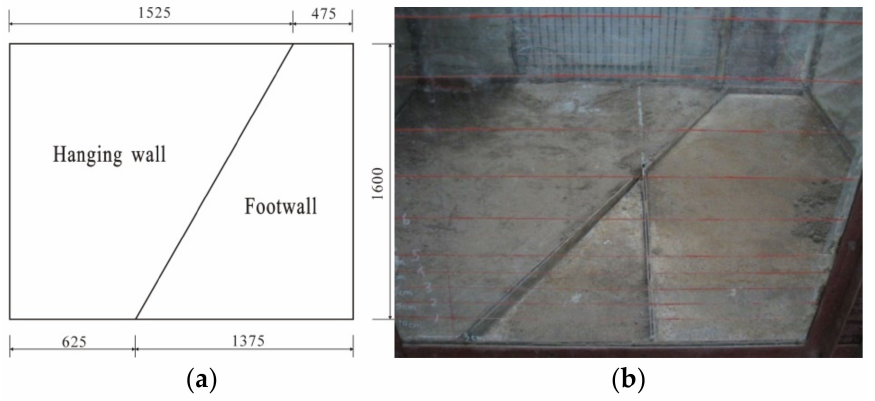
Figure 3. Schematic diagram of the bottom plate (unit: mm): ( a ) design of the bottom plate; ( b ) view of the spliced bottom plate.